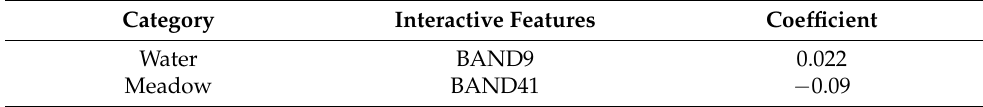
Table 9. Interaction characteristic coefficients of water body and